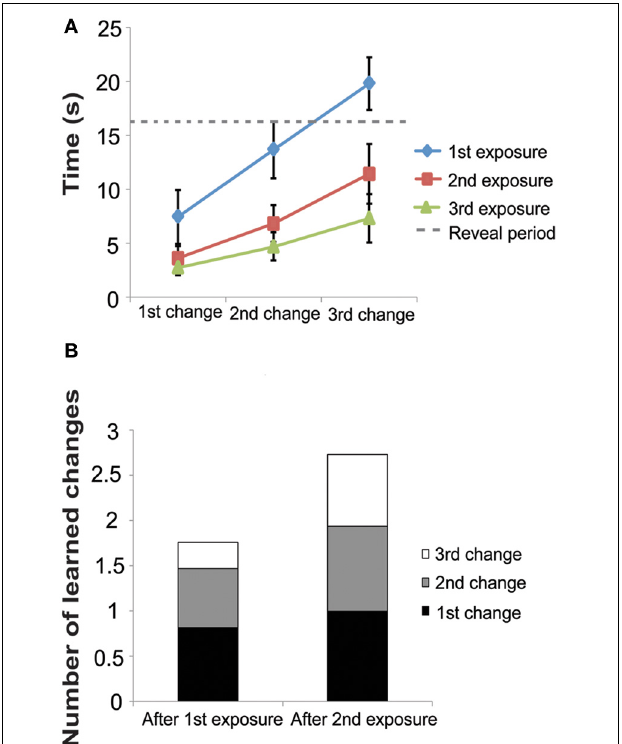
FIGURE 3 | Experiment 2 Study Phase. (A) Latency to find changes decreased with each exposure in the study phase. Note that all three changes were presented simultaneously (see Figure 1A ) and thus subjects responded to each change as they noticed it. (B) Using our model, Equation (4), we estimate that after the second exposure subjects remember almost all three changes. These data are taken from the time to detect the each change after each exposure. The first bar labeled “After 1st Exposure” was taken from latency to find each change during the second exposure and the second bar labeled “After 2nd Exposure” was taken from the latency to find each change during the third exposure. Subjects were not exposed to the images a fourth time and therefore we do not have the latency to estimate each change after the 3rd exposure.